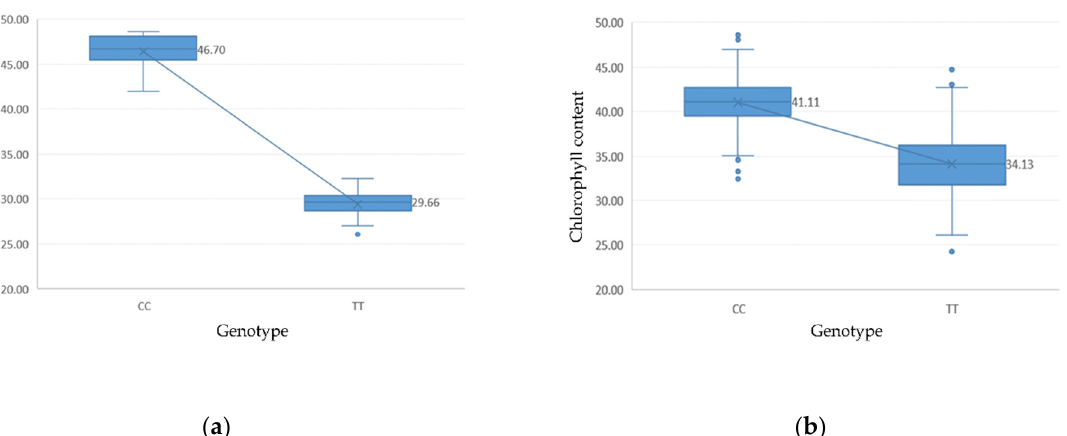
Figure 4. ( a ) The genotype–phenotype association of SNP AX-176820297 showing 10 peanut accessions with the highest chlorophyll content and 10 with the lowest chlorophyll content; ( b ) The genotype–phenotype association of SNP AX-176820297 with 392 peanut accessions. The average value of each set of data is marked in patterns.